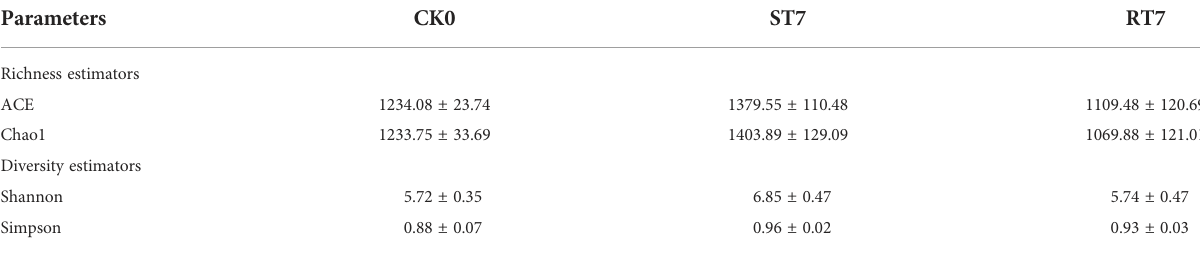
TABLE 3 Illumina high-throughput bacterial diversity richness, diversity index (Shannon and Simpson), and estimated OTU richness (ACE and Chao1) of the intestinal bacterial of golden pompano.